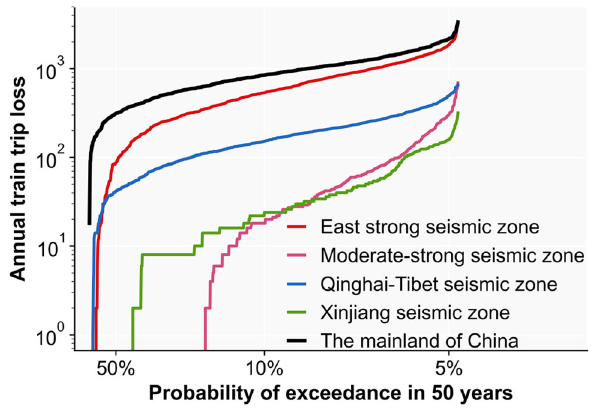
Fig. 9 Annual train trip loss of the Chinese railway